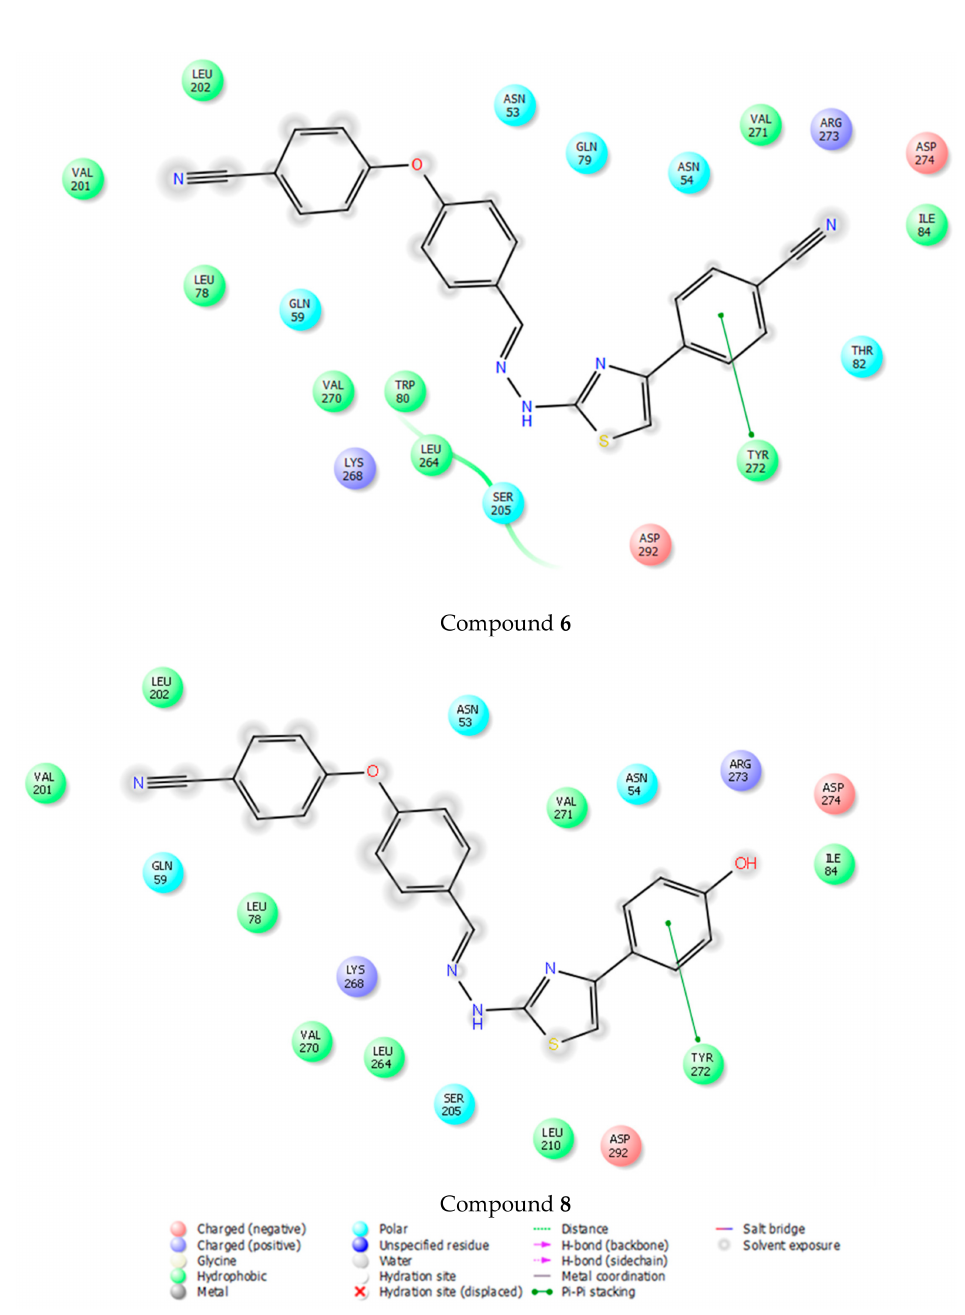
Figure 5. Docking interactions of compounds 6 and 8 with proper residues in the active site of